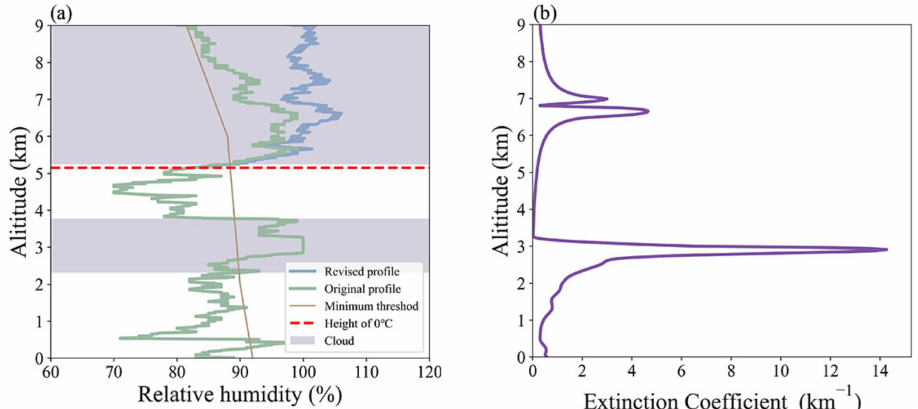
Figure 2. ( a ) Relative humidity profile at 00:04 28 June 2019 (BJT). The green line represents the original profile, while the blue line represents the revised profile. The red dotted line represents the height of 0 ◦ C, and the brown line indicates the minimum humidity threshold. The purple areas represent the height at which the clouds appear; ( b ) the extinction coefficient profile at 00:02 28 June 2019 (BJT). Assuming that the cloud extinction threshold above and below 0 ◦ C does not change with elevation, the extinction coefficient profile is further examined upward from the surface. The height corresponding to the first value greater than or equal to the threshold is regarded as the cloud base, and the first value smaller than the threshold is considered the cloud top. The distance between the cloud base and the cloud top is the cloud